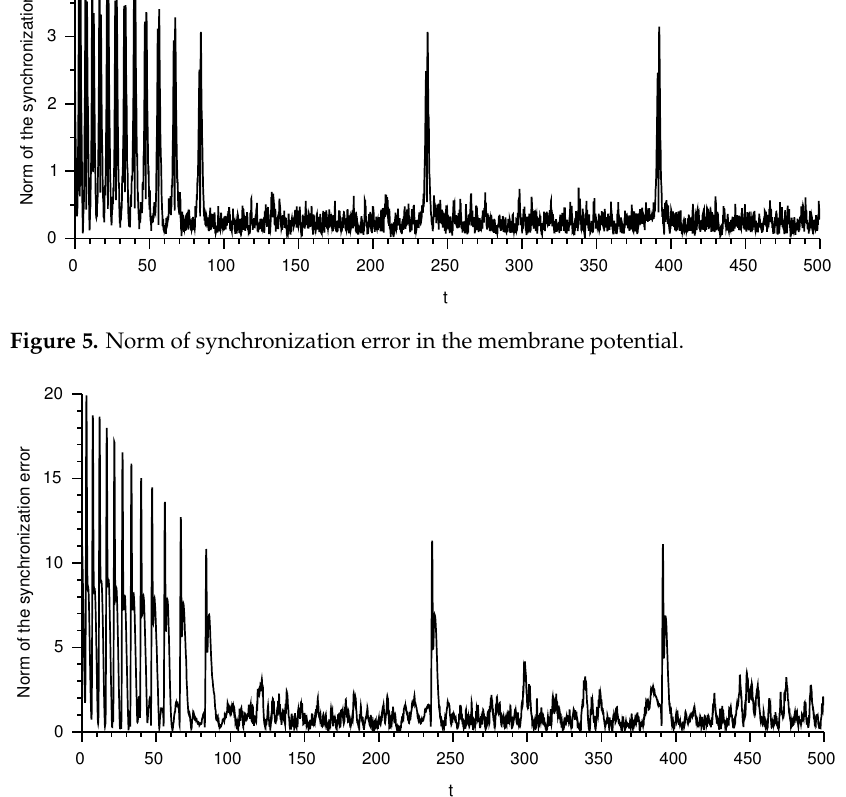
Figure 6. Norm of the synchronization error in the recovery variable.